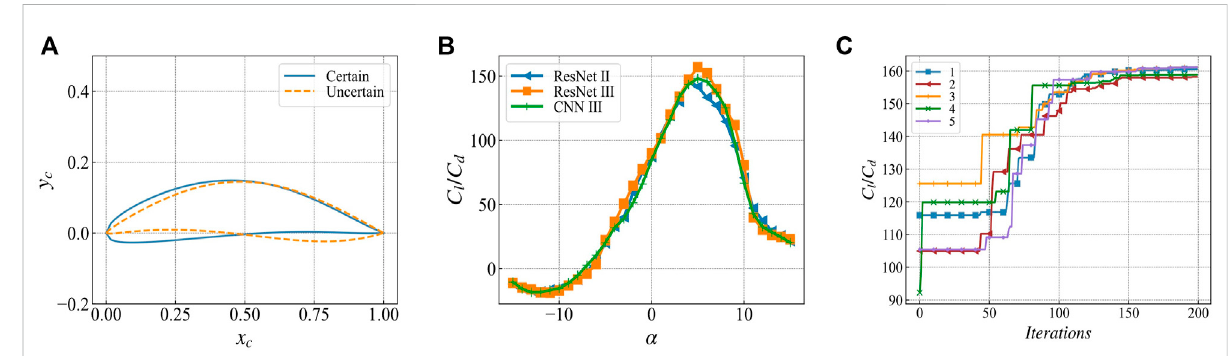
FIGURE 8 Geometry and lift-to-drag ratio prediction of the determined airfoil and the uncertain airfoil (A) solid line: the determined airfoil from the data set;dashedline:theuncertainairfoilgeneratedbyWGAN (B) differentnetworkpairsDeterminethelift-to-dragratiopredictionoftheairfoil,showing consistency (C) The lift-to-drag ratio predictions of the uncertain airfoil of different networks are signi fi cantly different.